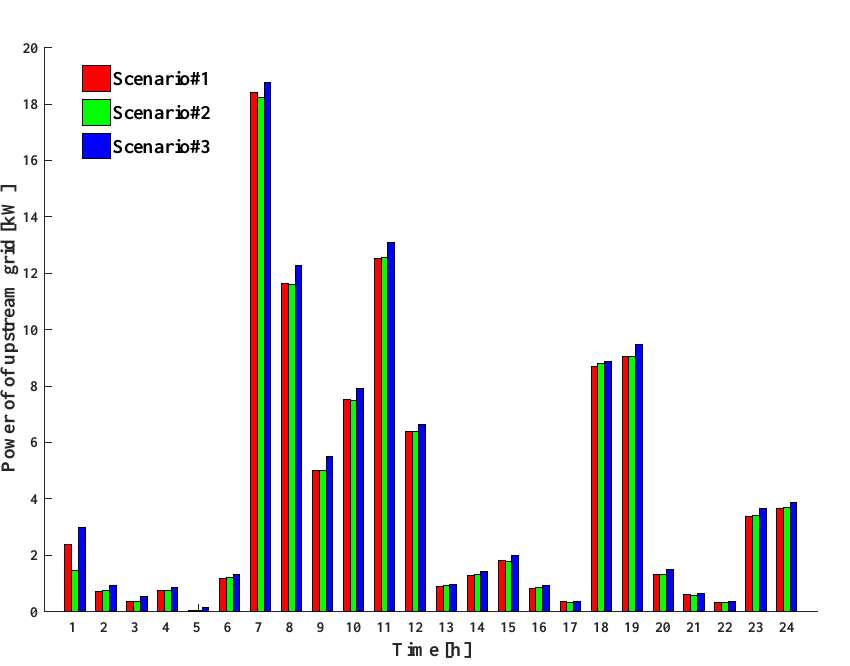
Figure 11. Upstream grid’s power profile for selling.